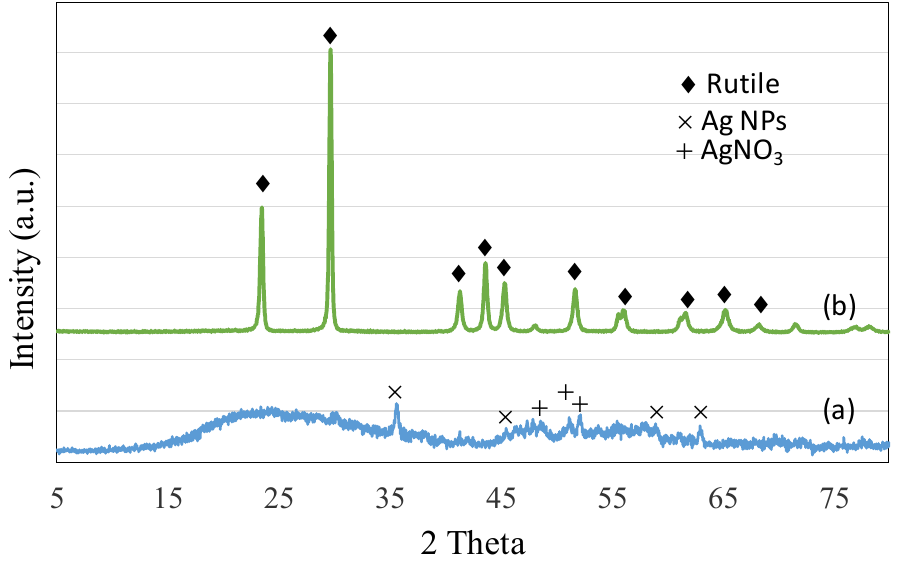
Figure 2. Powder X-ray diffraction spectra of (a) Ag nanoparticles (NPs) and (b) TiO 2 NPs. The spectra (a) represents Ag NPs with FCC structure and (b) shows TiO 2 NPs crystals with rutile phase